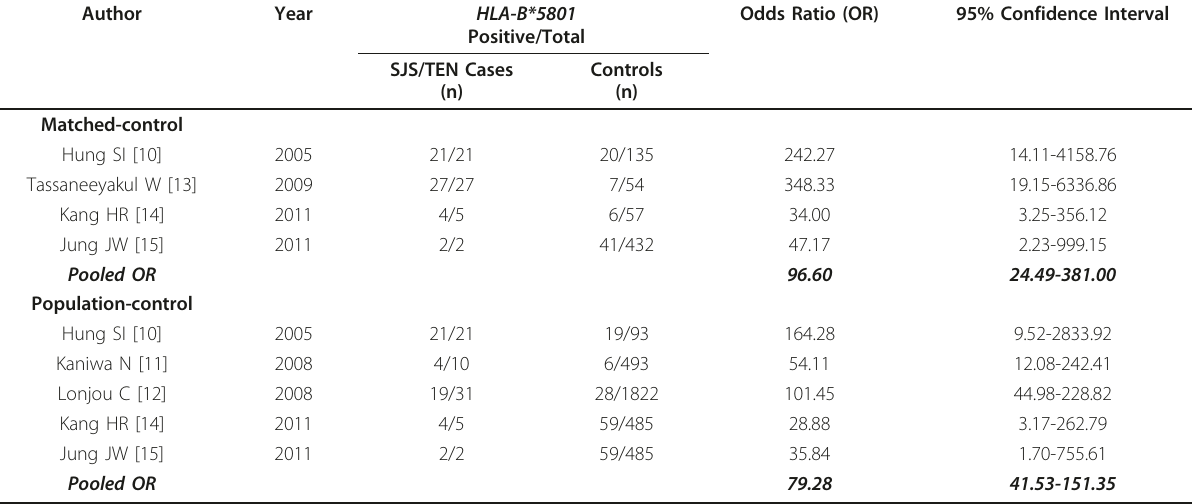
Table 3 Number of patients who had HLA-B*5801 allele positive and summary odds ratios